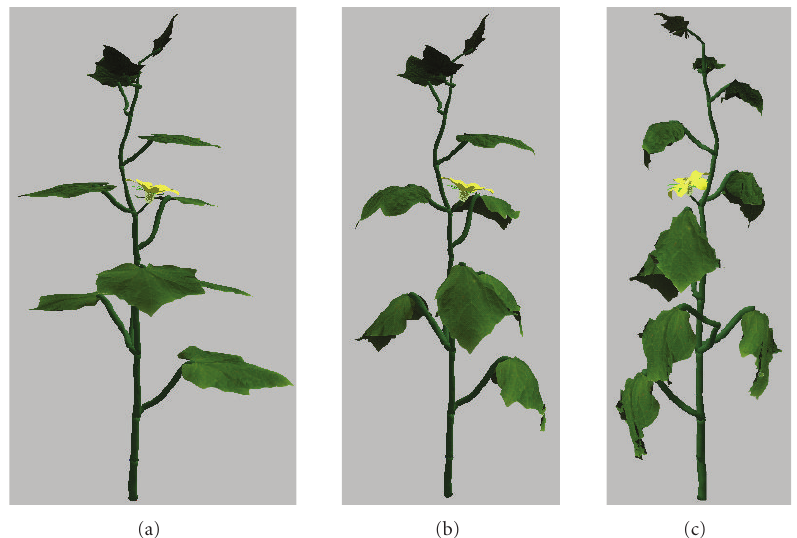
Figure 7: Three stages of a wilting cucumber plant: (a) none wilting, (b) slight wilting, and (c) acute wilting.